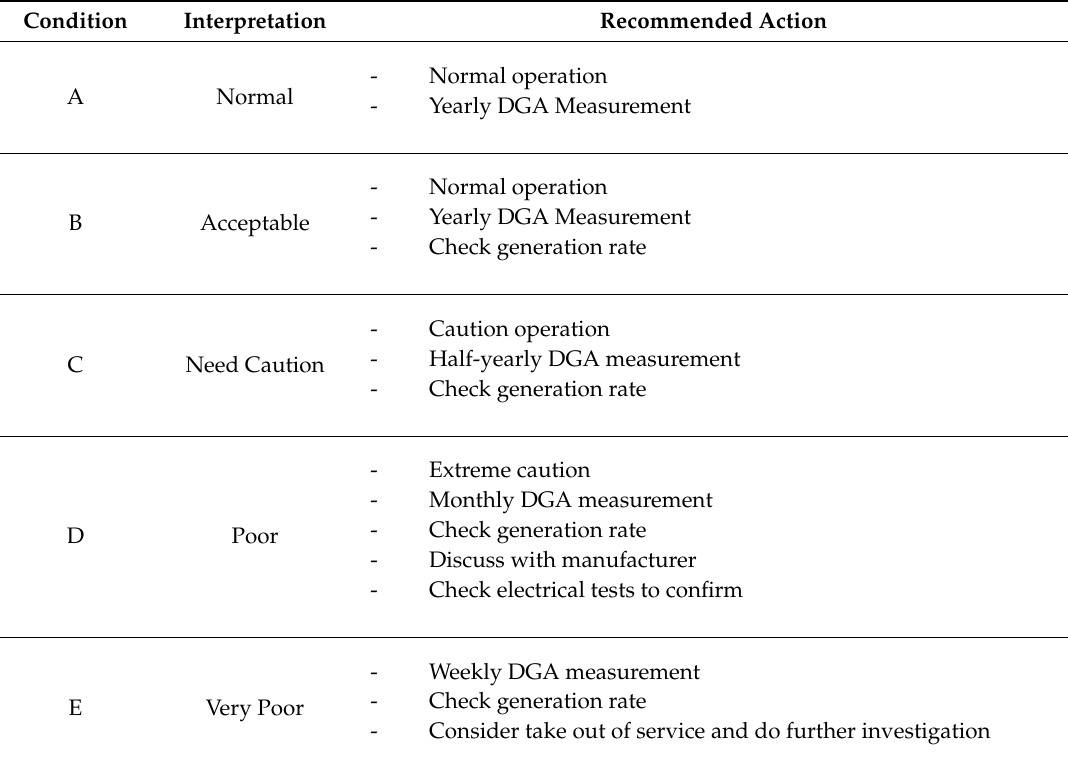
Table 10. Output of power transformer faults’ severity model.